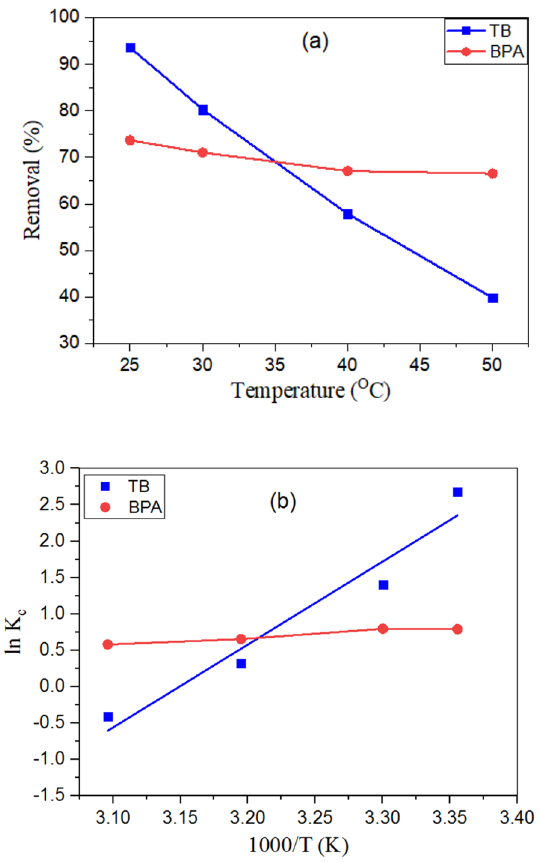
Figure 12. ( a ) Effect of temperature on efficiency of adsorption of TB and BPA onto FGS2, ( b ) Plot of lnk2 vs. 1/T, ( c ) Van’t Hoff plot for TB and BPA removal using FGS2 composites at different solution temperatures [pH: 3, agitation speed: 300 rpm, contact time 30 min and optimum adsorbent dose].